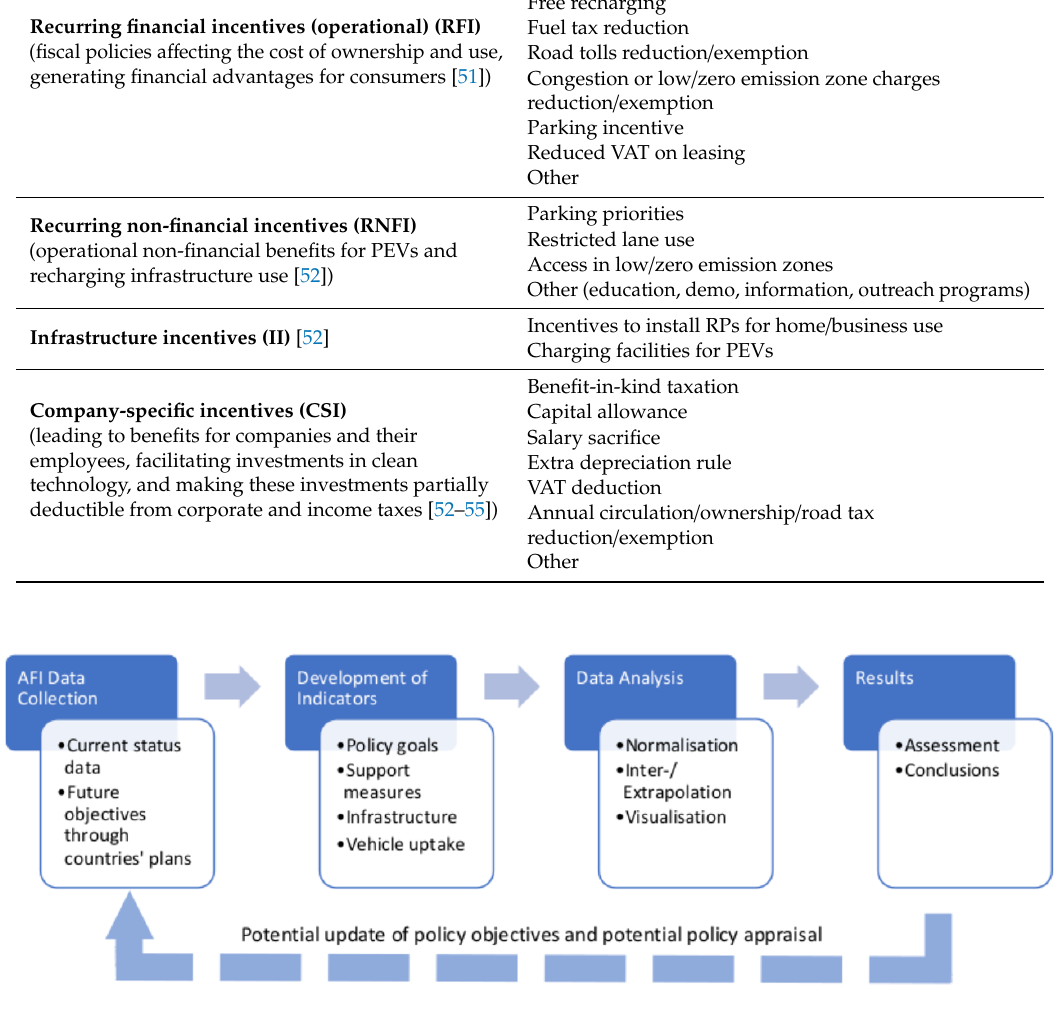
Table 1. Proposed classification of support measures.